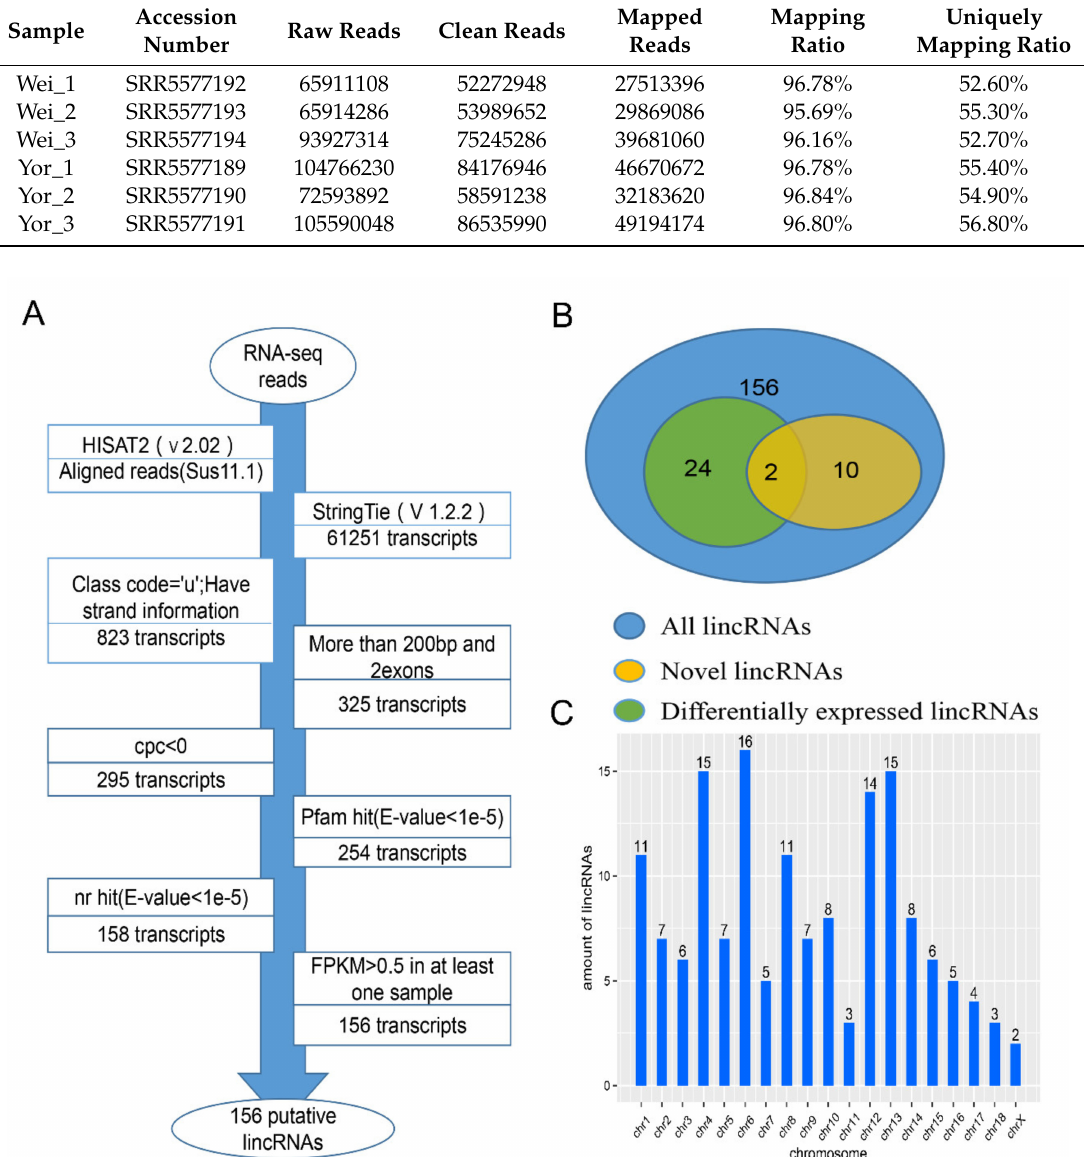
Table 1. Summary of data from RNA-Seq for Wei and Yorkshire pigs.